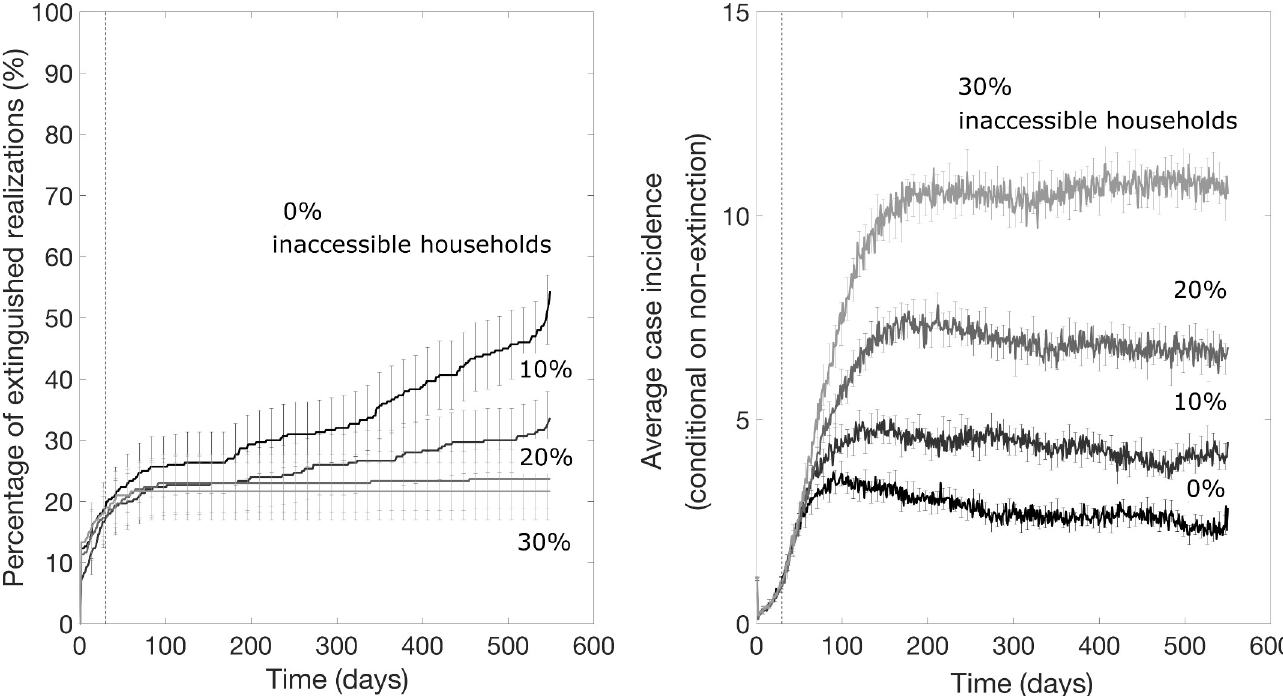
Fig 5. The impact of ring vaccination that starts 30 days after epidemic onset on the probability of outbreak extinction and the mean daily incidence curves for various percentage levels of inaccessible households, which do not participate in vaccination and do not provide contacts lists as explained in the text. These simulations were generated using the exponential transmission profile, but similar results were obtained using the gravity transmission profile described in the main text. The vertical dashed line indicates the timing of start of the ring vaccination